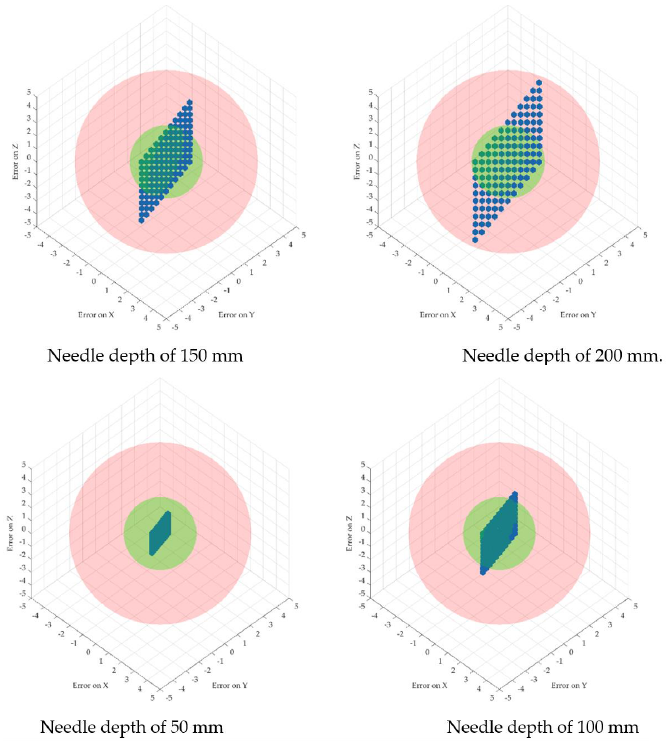
Figure 8. Needle tip-positioning errors for different